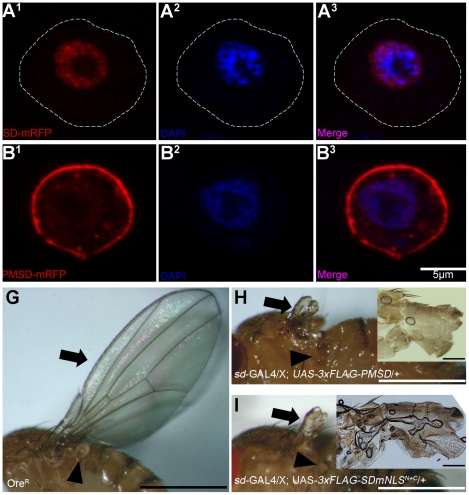
During wing development, 3xFLAG-PMSD and 3xFLAG-SD mNLSN+C act as dominant negative forms of Sd.(A and B) Localization of the indicated mRFP reporter tagged proteins in transiently transfected in S2 cells with DAPI stained nuclei and visualized via confocal microscopy. See Figs. 2A–G for details. (A) Sd-mRFP expression. Sd strongly localizes an mRFP tag to the nucleus. (B) PMSD-mRFP expression. Sd tagged with a N-terminal palmitoylation/myristoylation sequence (PMSD) and C-terminal mRFP tag shows strong localization to the cytoplasmic membrane of S2 cells. (C–E) Light micrographs of flies with the indicated genotypes. (C) Wildtype Oregon-R (OreR) fly. (D–E) Males containing either UAS-3xFLAG-PMSD or UAS-3xFLAG-SD mNLSN+C (see Fig. 3C) inserted on the 2nd chromosome and balanced over CyO were crossed (two independent lines/insert) to virgin females homozygous for sd-GAL4 and the resultant progeny were scored. Insets are magnified views of the wing tissue. Scale bars are 1 mm (D–E) or 0.1 mm (D and E insets). Arrows indicate the wing, while arrowheads indicate the haltere. (D) Female fly containing UAS-3xFLAG-PMSD under the control of sd-GAL4. Almost no wing or haltere tissue is present. (E) Female fly containing UAS-3xFLAG-mNLSN+C under the control of sd-GAL4. Again, virtually no wing or haltere tissue is present.